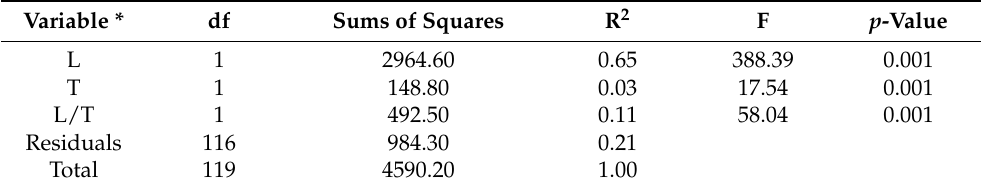
Table 3. Results of nonparametric multivariate analysis of variance (NPMANONA).